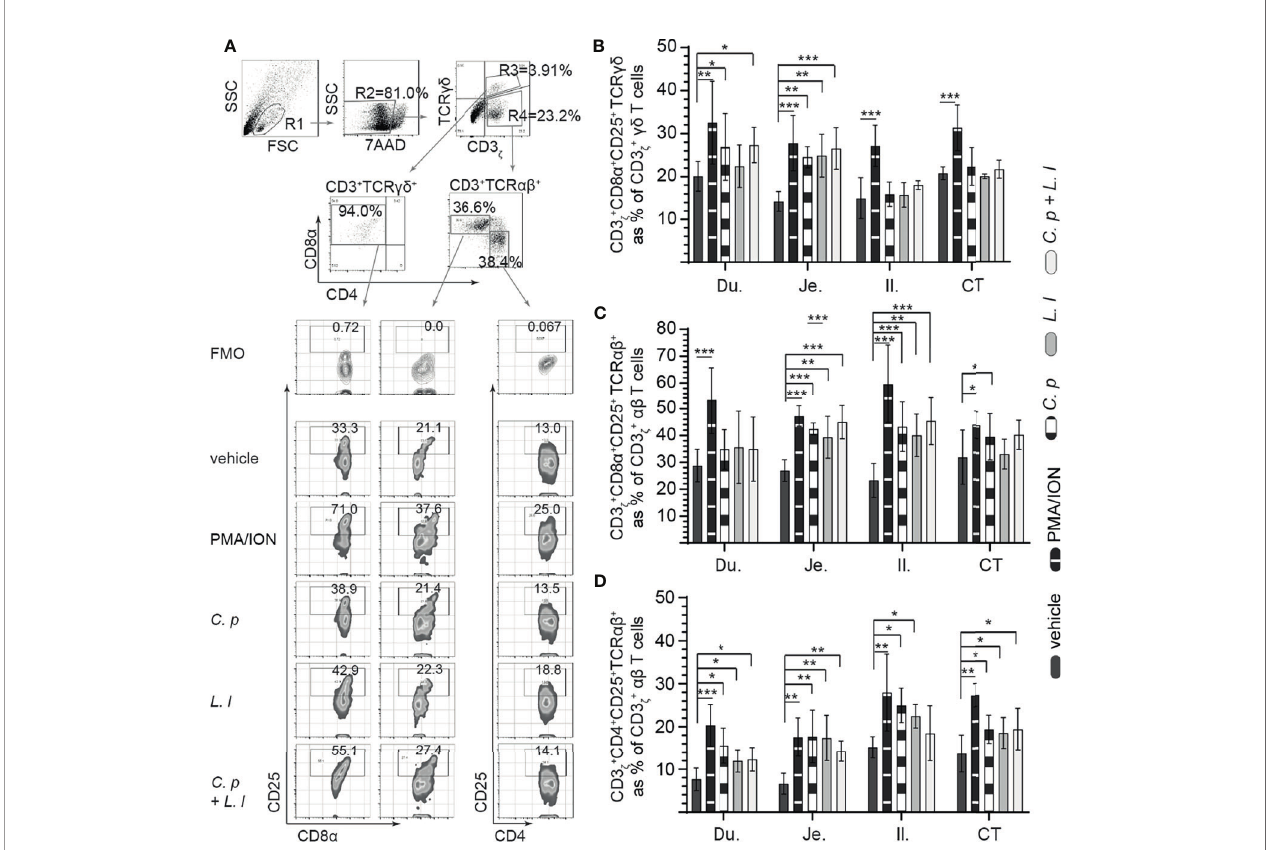
FIGURE 3 | Ex vivo induction of CD25+ small intestinal mononuclear cells by both C perfringens and L. lactis . Small intestine mononuclear cells ( n = 6) were isolated from the duodenum, jejunum, ileum, and cecal tonsils. Cells were stimulated with medium alone (vehicle), PMA (50 ng/ml) plus ION (1 m g/ml), C perfringens (1 MOI), L. lactis (MOI = 1), and combination of C perfringens (MOI = 1) and L. lactis (MOI = 1). Mononuclear cells were analyzed at 18 h poststimulation by fl ow cytometry for surface expression of CD25. (A) Dot plots and density plot demonstrating the gating strategy utilized to de fi ne the frequency of (B) CD3 z +CD8 a +CD25+ gd T cells, (C) CD3 z +CD8 a +CD25+ ab T cells, and (D) CD3 z +CD4+CD25+ ab T cells from the duodenum, jejunum, ileum, and cecal tonsil. Paired t -test was used to assess normal distribution and test signi fi cance. *(p < 0.05), **(p < 0.001) and ***(p < 0.0005) indicates a statistically signi fi cant difference. The mean ± SD value are